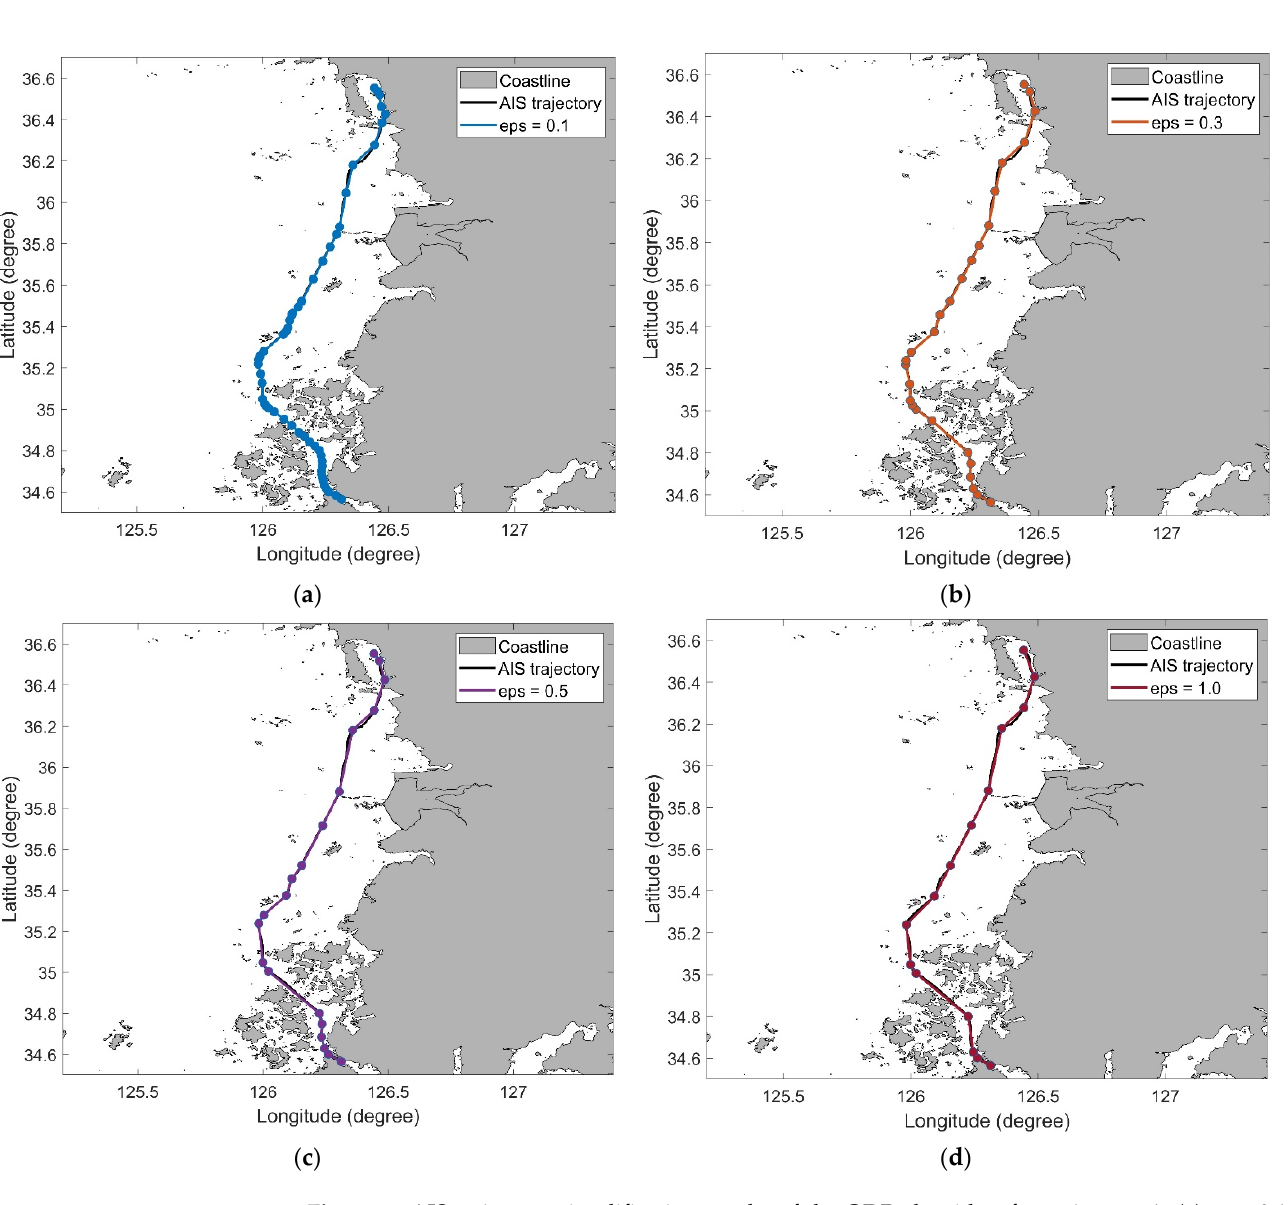
Figure 8. AIS trajectory simplification results of the ODP algorithm for trajectory 4: ( a ) 𝜖 = 0.1 ; ( b ) 𝜖 = 0.3 ; ( c ) 𝜖 = 0.5 ; ( d ) 𝜖 = 1.0 . Table 3. Comparison of the results obtained using the ODP and DP algorithms for trajectory 10. ODP Algorithm DP